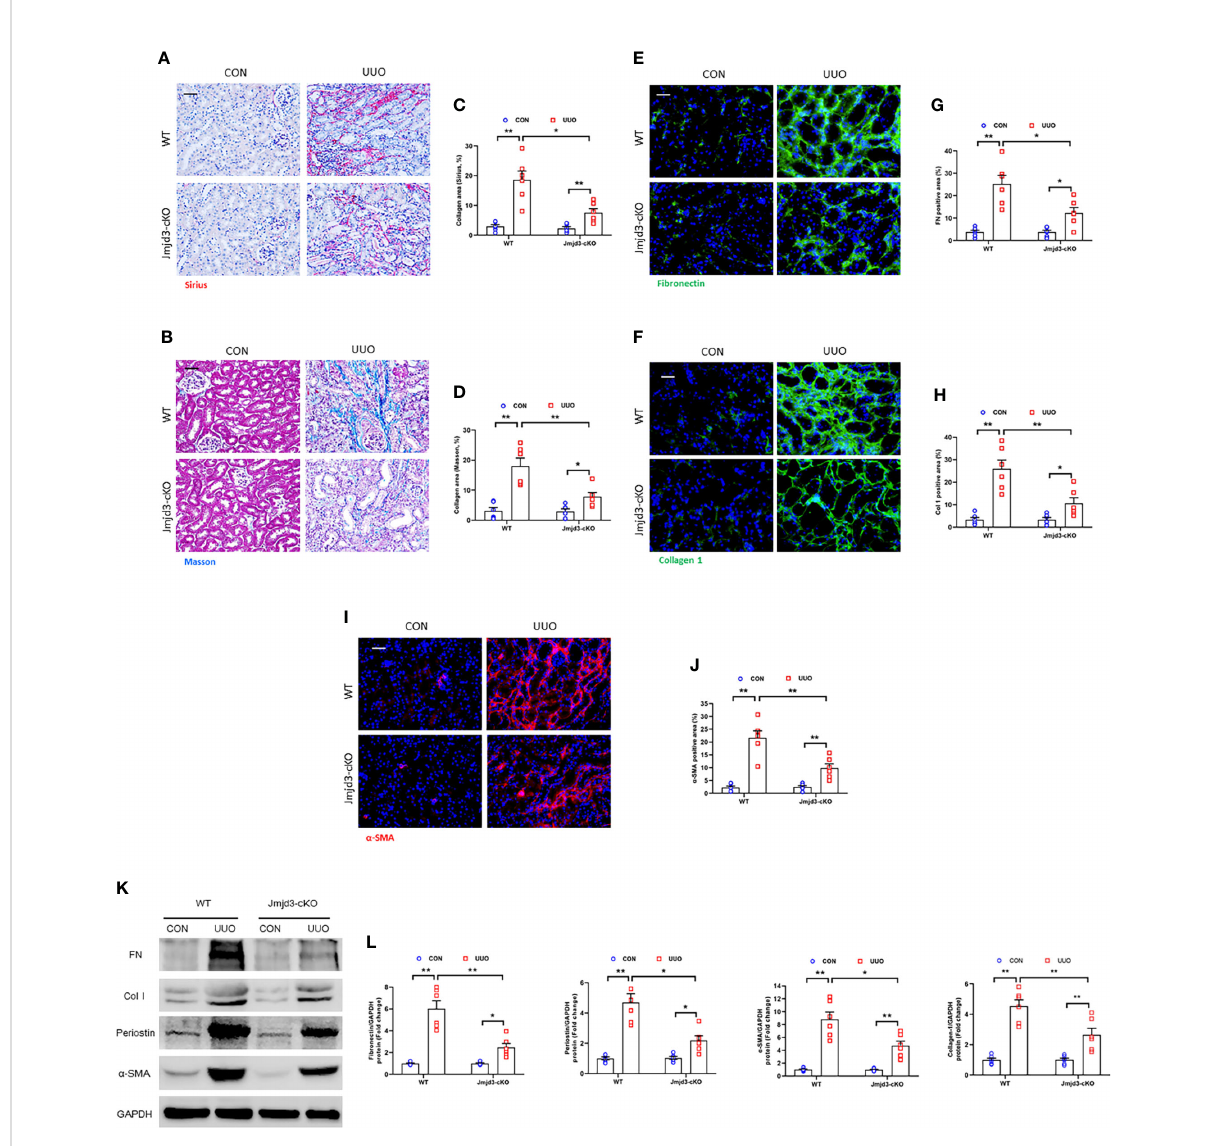
FIGURE 5 Myeloid Jmjd3 deletion reduces renal fi brosis, extracellular matrix protein expression, and myo fi broblasts accumulation in obstructive nephropathy. (A, B) Kidney sections were stained with Sirius red or Masson ’ s Trichrome reagent. (C, D) Quantitative analysis of collagen area in the kidneys. (E, F) Kidney sections were stained for fi bronectin (green) or collagen I (green). (G, H) Quantitative analysis of fi bronectin or collagen I-positive area. (I) Kidney sections were stained for a -SMA (red). (J) Quantitative analysis of a -SMA -positive area in the kidneys. (K) Representative western blots show protein expression of fi bronectin, collagen I, periostin and a -SMA in the kidneys. (L) Quantitative analysis of ECM and a -SMA protein levels in the kidneys. * P <0.05 or ** P <0.01; n = 6; Bar = 50 m m. WT, wild-type; cKO, conditional